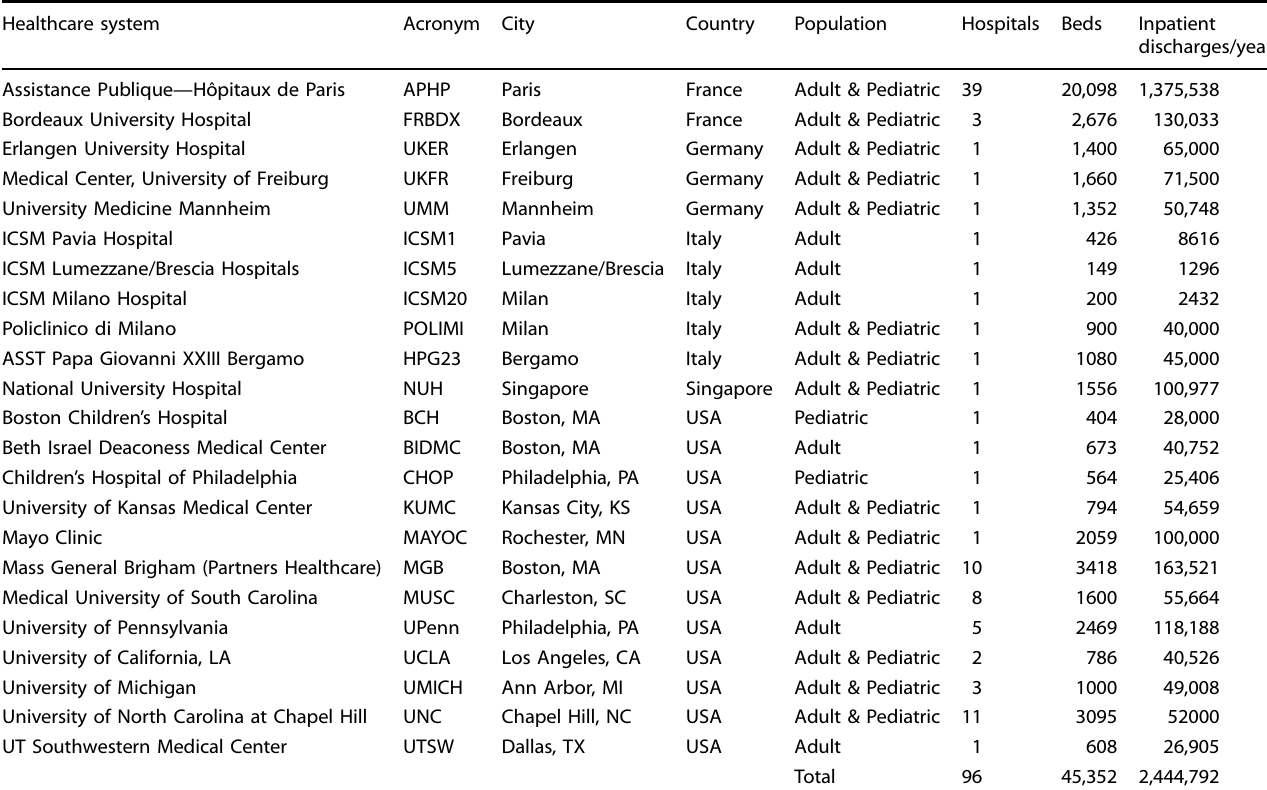
Table 1. Sites contributing data to the